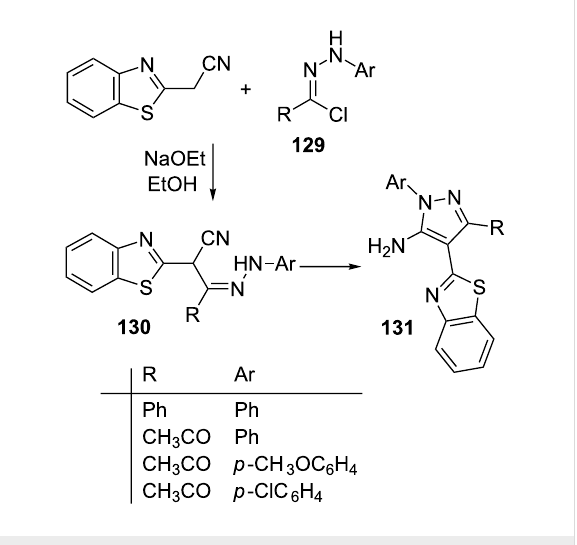
Hydrazonoyl chlorides 129 on treatment with benzothiazole-2-